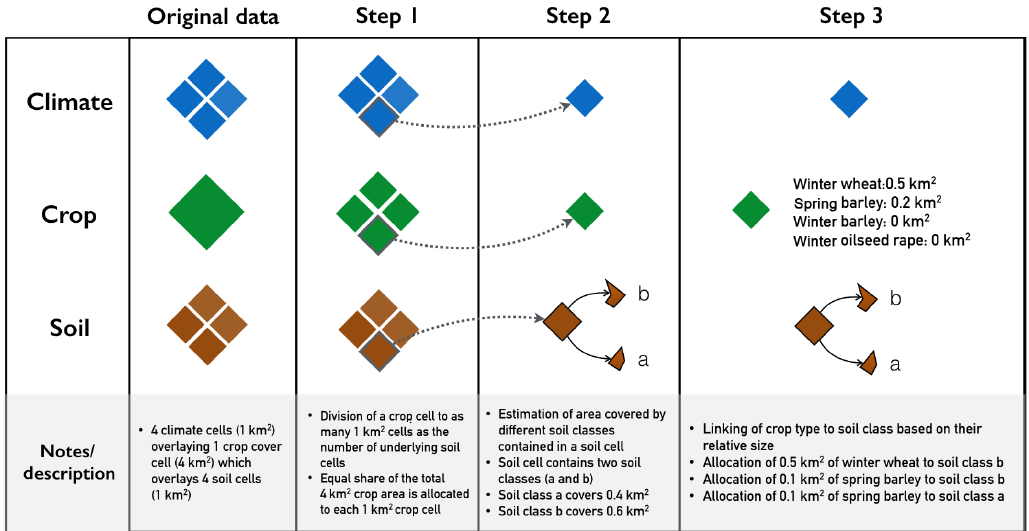
Figure 3. Description of the processing of spatial data on climate, soil and crop cover. Example values are used for the size (km 2 ) of soil classes (step 2) and the area covered by different crops (step 3) to demonstrate the process